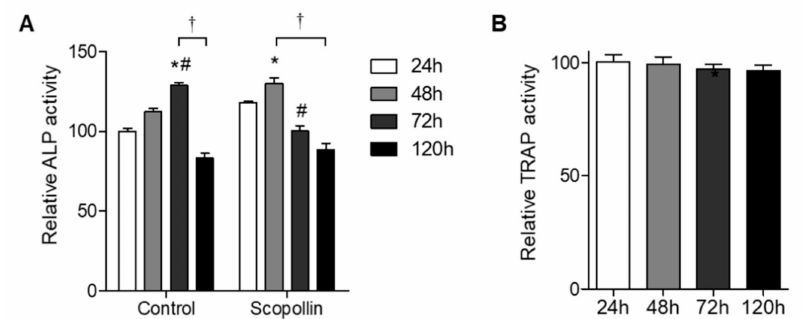
Figure 5. Scopolin treatment increased osteoblast di ff erentiation in a co-culture of isolated monocytes and MC3T3-E1 osteoblastic cells. Isolated monocyte (4 × 10 4 cells / well) and MC3T3-E1 cells (2 × 10 4 cells / well) were treated with 5 µ M of scopolin, and ( A ) alkaline phosphatase (ALP) and ( B ) tartrate-resistant acid phosphatase (TRAP) activity were measured at 24, 48, 72, and 120 h. At least three di ff erent experiments were performed. * p < 0.05 vs. 24 h, # p < 0.05 vs. 48 h, and † p < 0.05 vs. 120 h (Tukey’s honest significant di ff erence post hoc test, analysis of